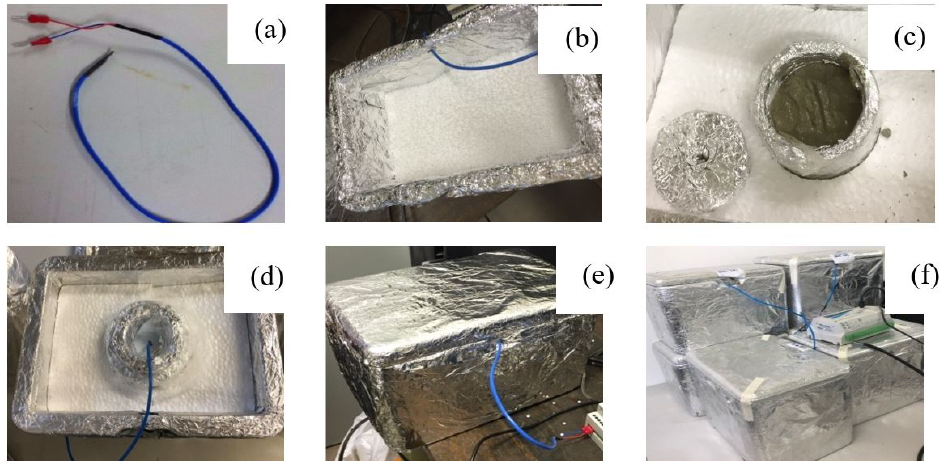
Figure 3. Sequence of the assembly of the boxes for the initial setting time test. (a) thermocouple type T; (b) expanded polypropylene box with cradle for small expanded polypropylene spheres; (c) expanded polypropylene cup positioned inside the box, embedded in expanding polypropylene plate, receiving the mortar sample within; (d) thermocouple positioned within the sample, properly capped and sealed with silicone; (e) closed box with the sample inside and thermocouple exiting the external medium, connecting to the data collector; (f) system ready and connected to the data